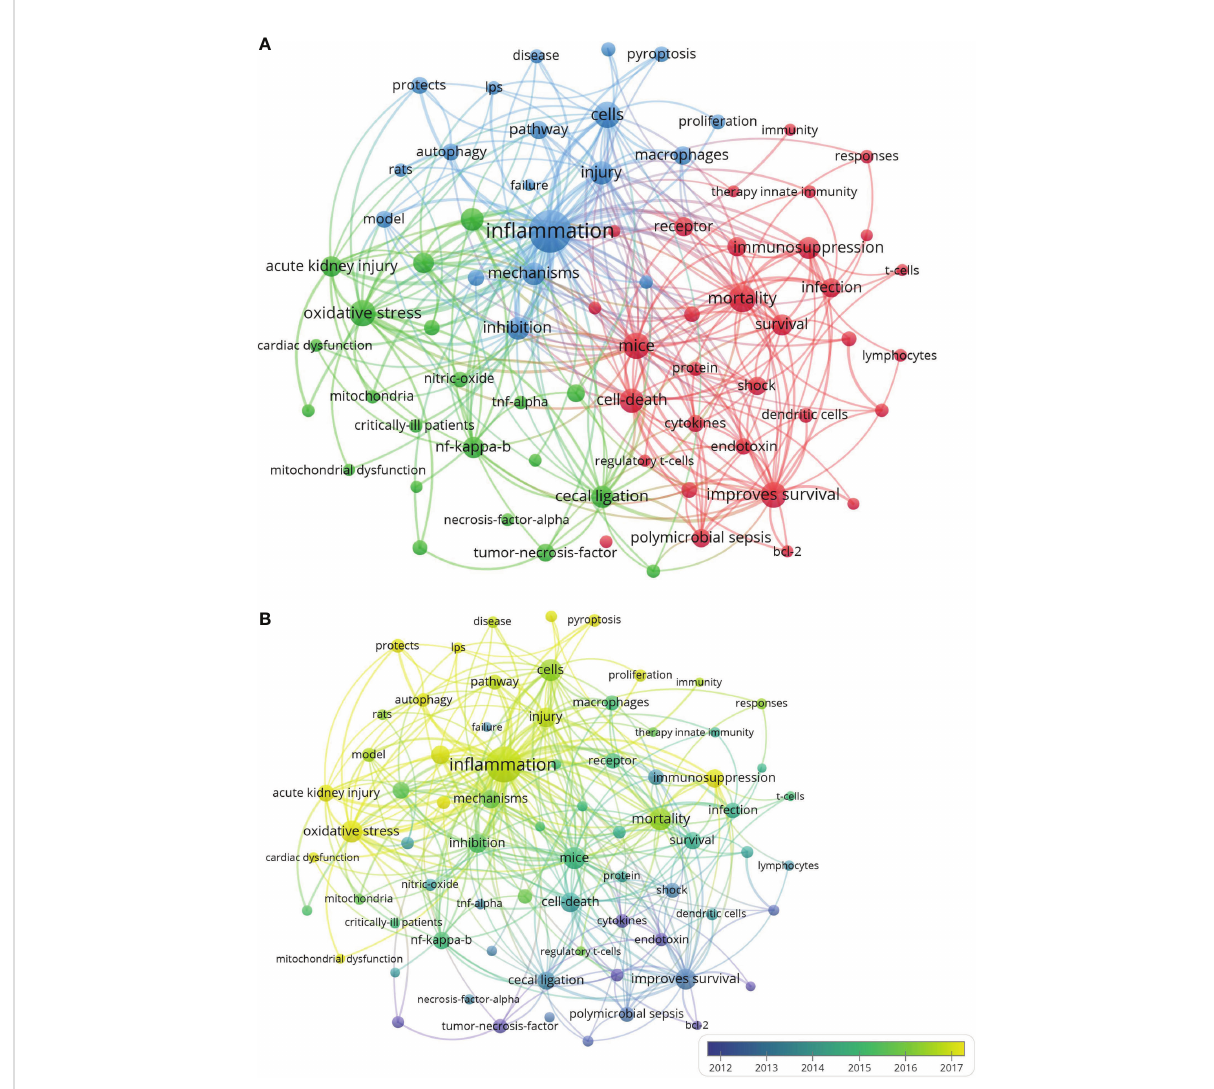
FIGURE 7 The analysis of keywords in publications on sepsis and programmed cell death. (A) Mapping the keywords within the fi eld of sepsis and programmed cell death. All the keywords were classi fi ed into three clusters in line with different colors: oxidative stress-related research (left, in green), immunosuppression-related research (right, in red), and in fl ammation-related research (top, in blue). The larger cycle represents the keywords that presented with a higher frequency. (B) Distribution of keywords is shown in accordance with the appearance for the average time. The blue color represents words during the early stage, while the yellow color represents the words that appeared in recent